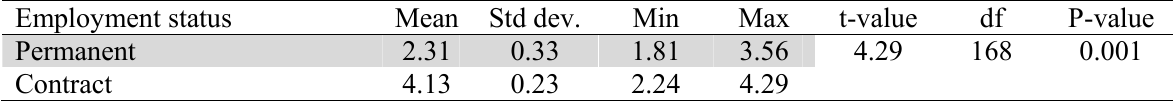
The summary of ANOVA test on the effects of educational background Groups Sum of squares df Mean of squares Between groups Inside groups